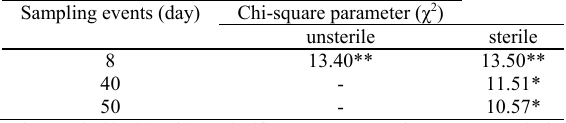
Table 1: Analysis of variance ( χ 2 -value) of culturable E. coli NAR in soil as affected by zeolite and nanozeolite